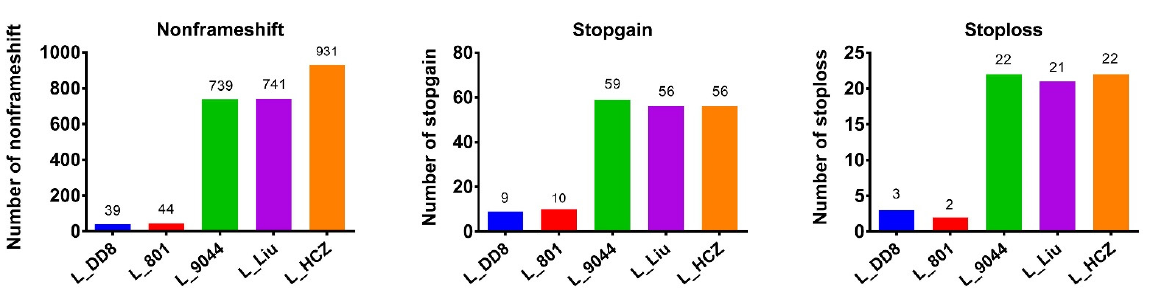
Figure 3. SNPs/InDels in the coding region. SNV: single-nucleotide variations. Stopgain: variations leading to early termination of codon in the coding region. Stoploss: variations leading to loss of normal termination codon in the coding region.